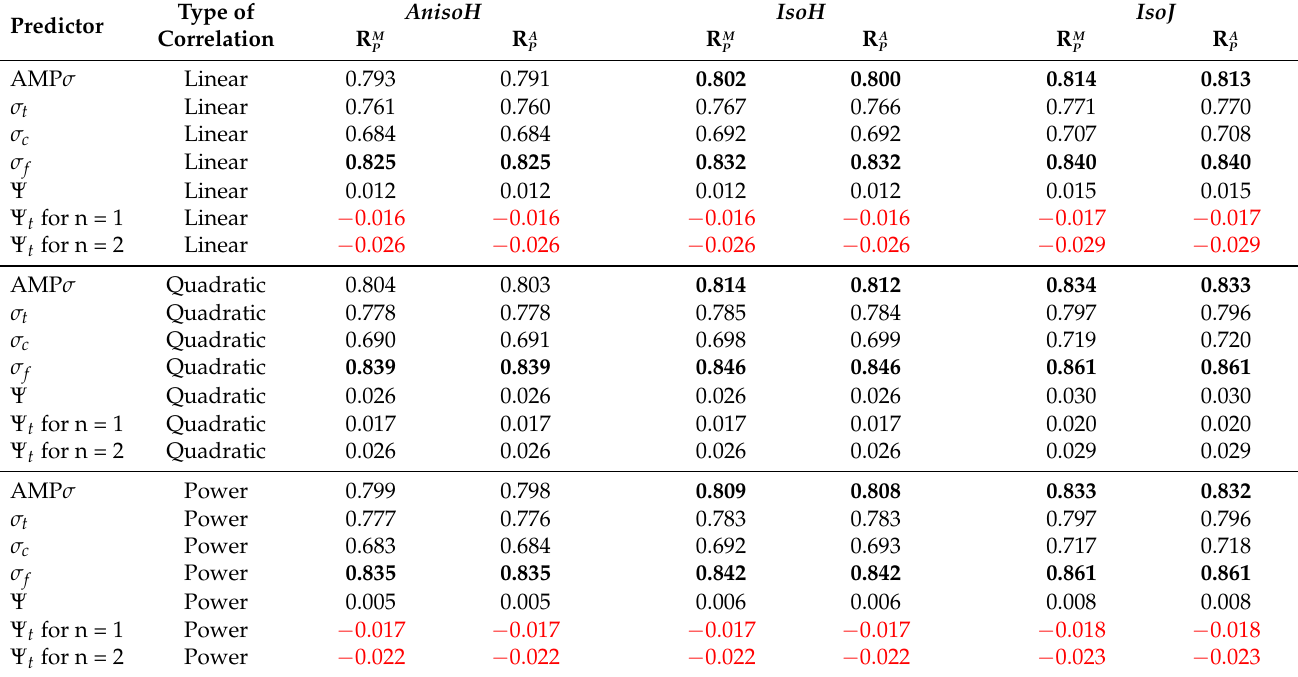
Table 4. Weighted Pearson correlation coefficients obtained for GLT = 80, constitutive models AnisoH, IsoH and IsoJ and using C3D4 elements: for the maximum variable throughout the cycle, R M , and for the amplitude throughout the cycle, R A . The predictors analysed in this case are: the P P absolute maximum principal stress (AMP σ ), the maximum tensile and compressive stresses ( σ t and σ c , respectively), the fluctuation of stresses ( σ f ), the mechanical stimulus at the continuum level ( Ψ ) and at the tissue level ( Ψ t ) for two values of n . Values higher than 0.8 are highlighted in boldface; negative values are in red.